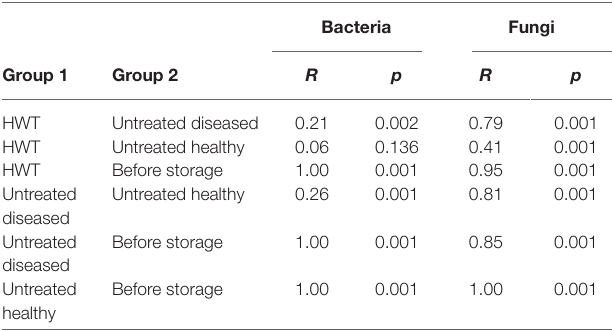
TABLE 1 | Pairwise ANOSIM results calculating significant differences in bacterial and fungal composition associated with differentially treated apple groups. Bacteria